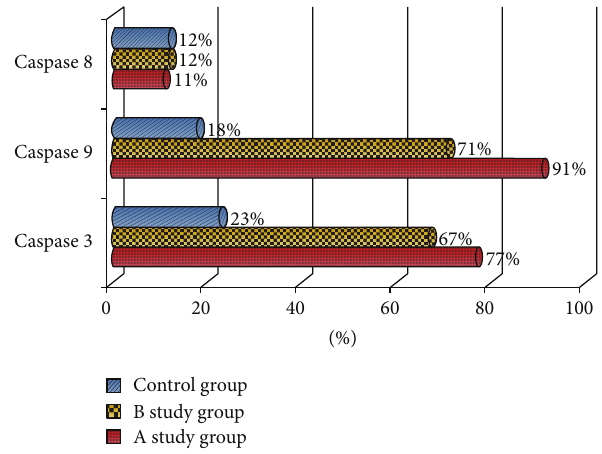
Figure 2: Percentage of positive caspases expression in cells of oviduct epithelium. Positive expression of caspase 8 was rare in all three groups. Positive immunoprecipitation of caspases 3 and 9 was observed more frequently in the study groups than in the control